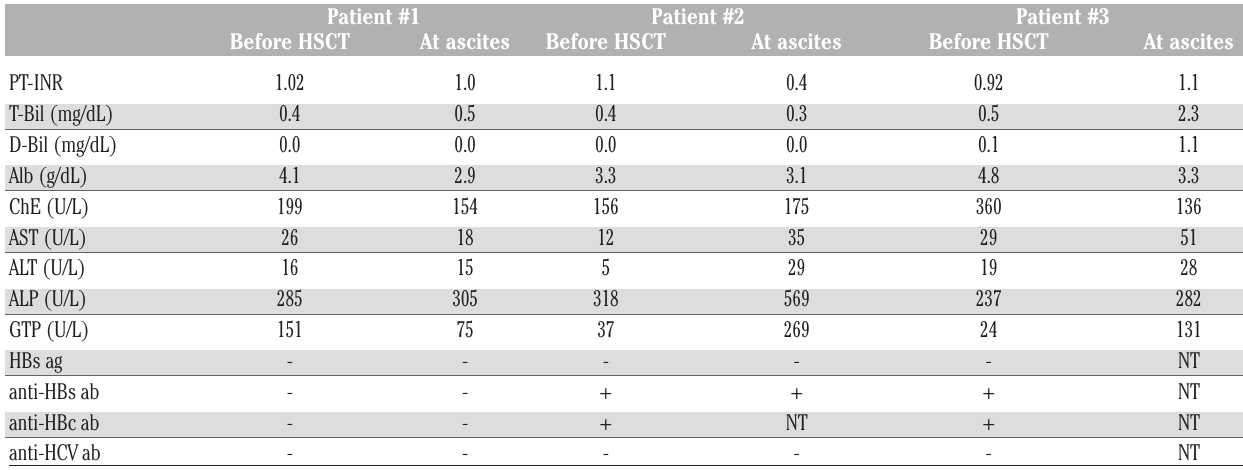
Table 1. Laboratory findings of the three patients.